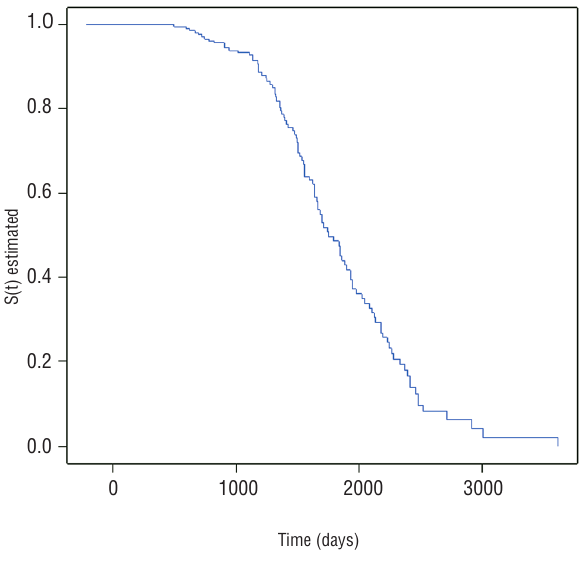
Figure 3 - Disease-free survival curve (Kaplan-Meier estimates) for RT.